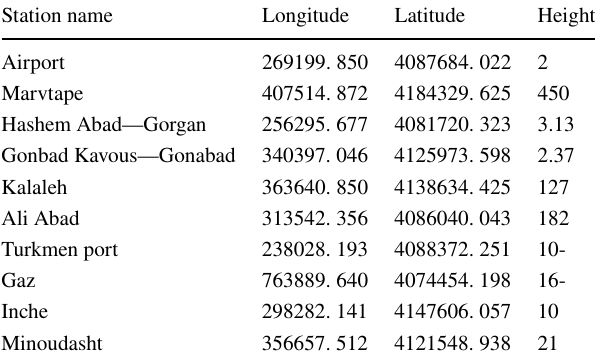
Table 1 Characteristics of the studied synoptic stations